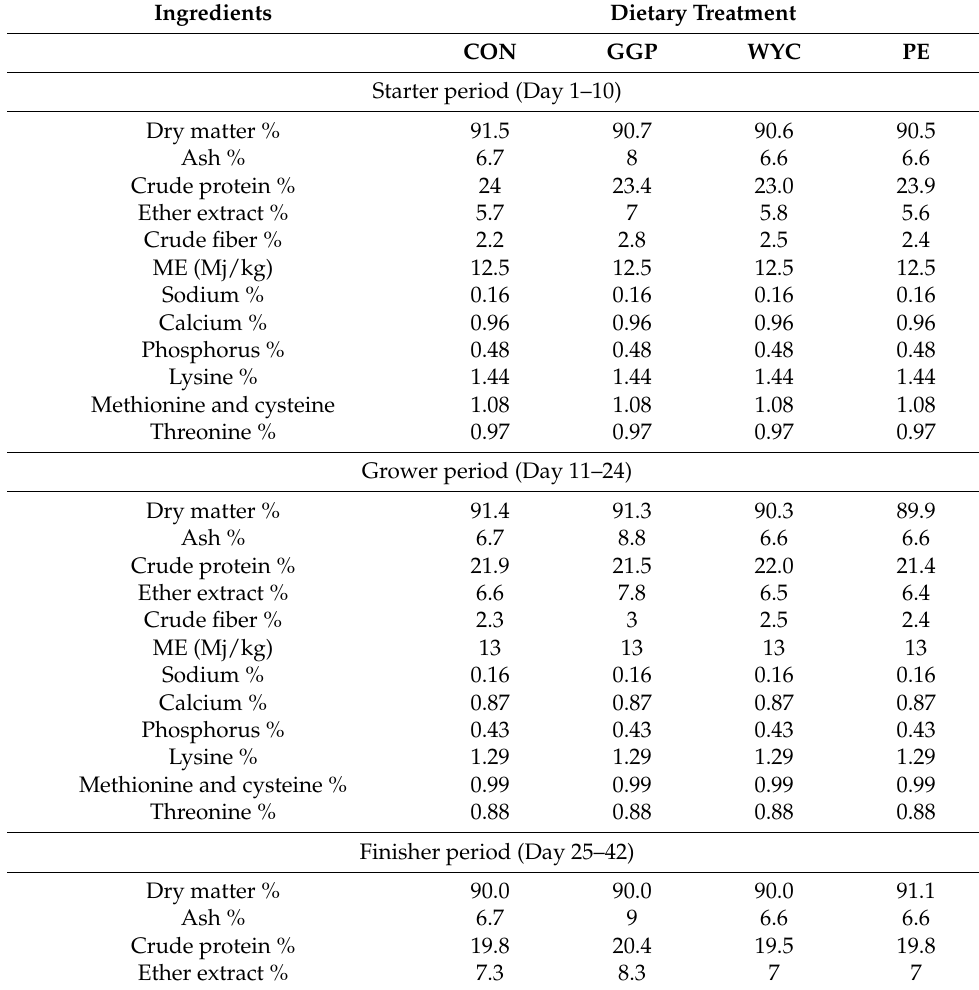
Table 2. Composition (%) and calculated analysis of the starting (0–10 day), growing (11–24 day), and finishing (25–42 day) phase of the control (CON), ground grape pomace (GGP), wine lees (rich in yeast cell walls) extract (WYC), and grape stem extract (PE)